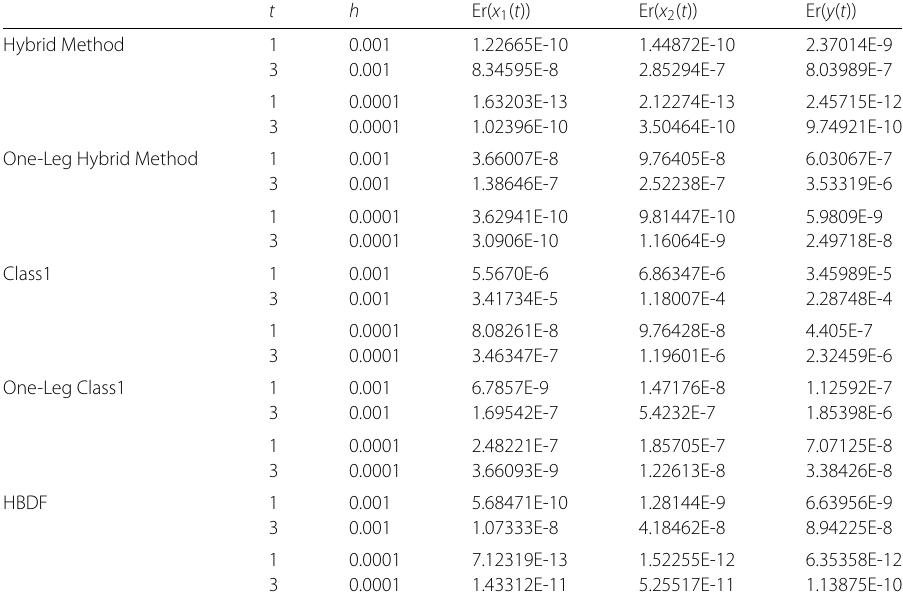
Table 8 The error of the third